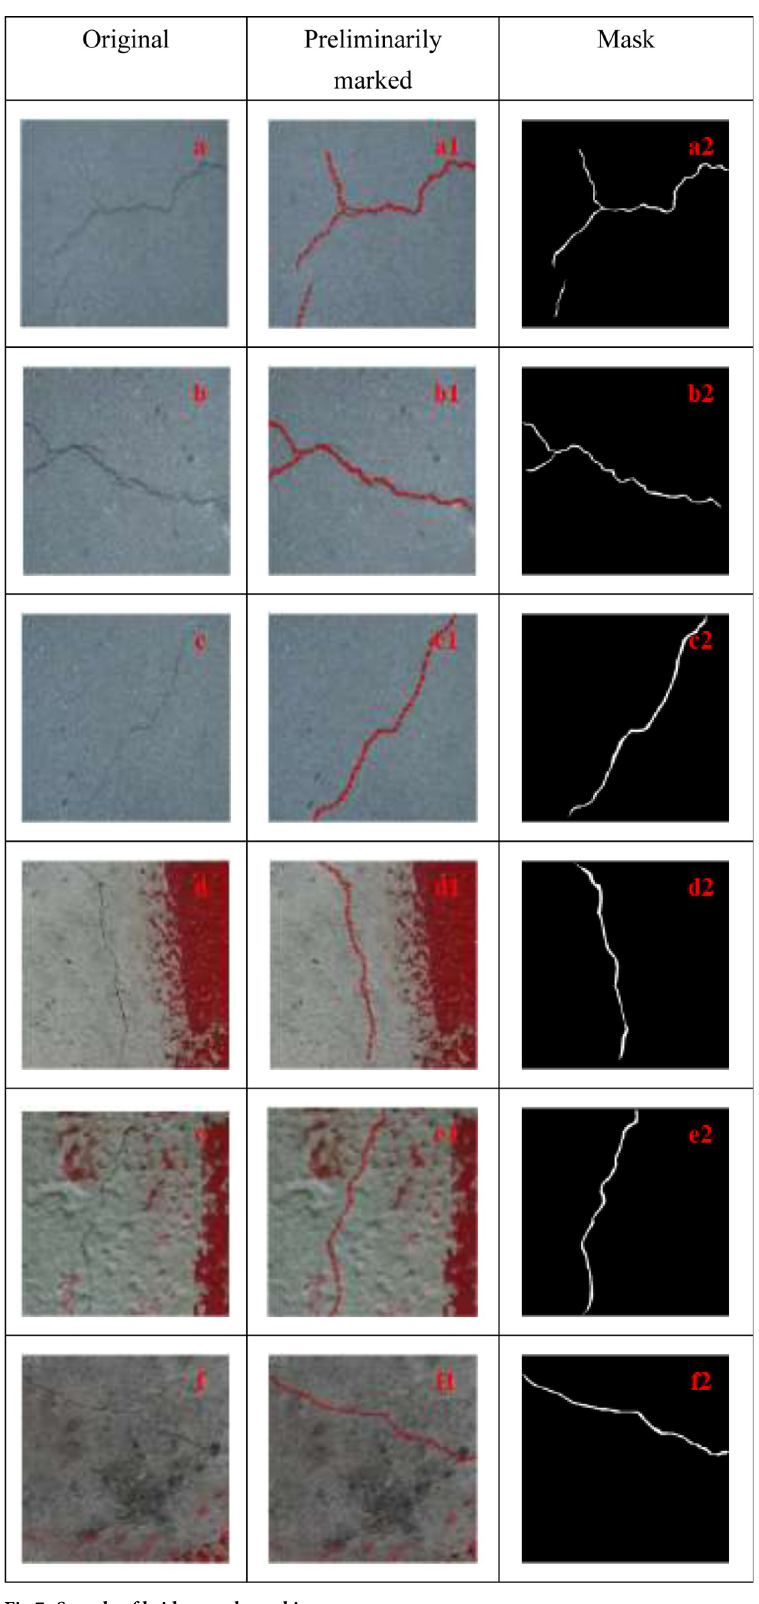
Fig 7. Sample of bridge crack